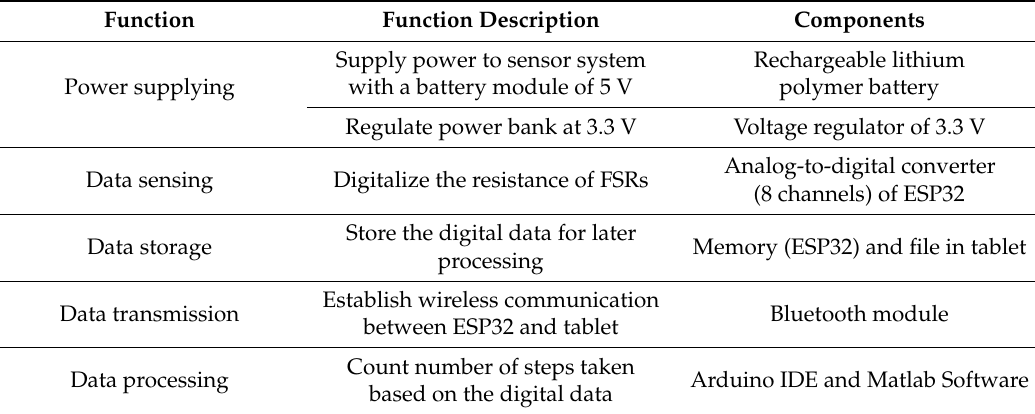
Figure 1. ( A ). Architecture design of instrumented insole; ( B ). Location of FSRs. Table 1. Analog functions designed for the instrumented Table 1. Analog functions designed for the instrumented insole.